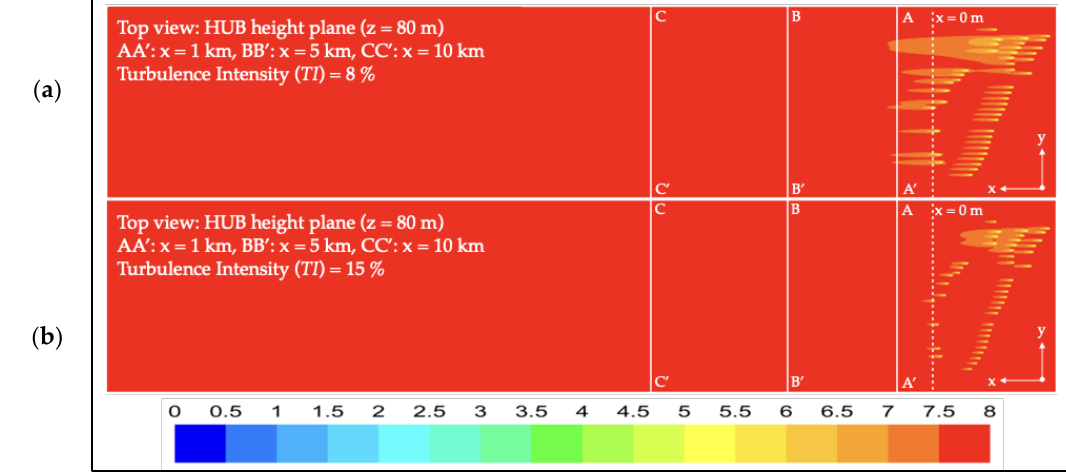
Figure 8. Velocity deficit (m/s) at hub height. ( a ) TI = 8%. ( b ) TI = 15%.